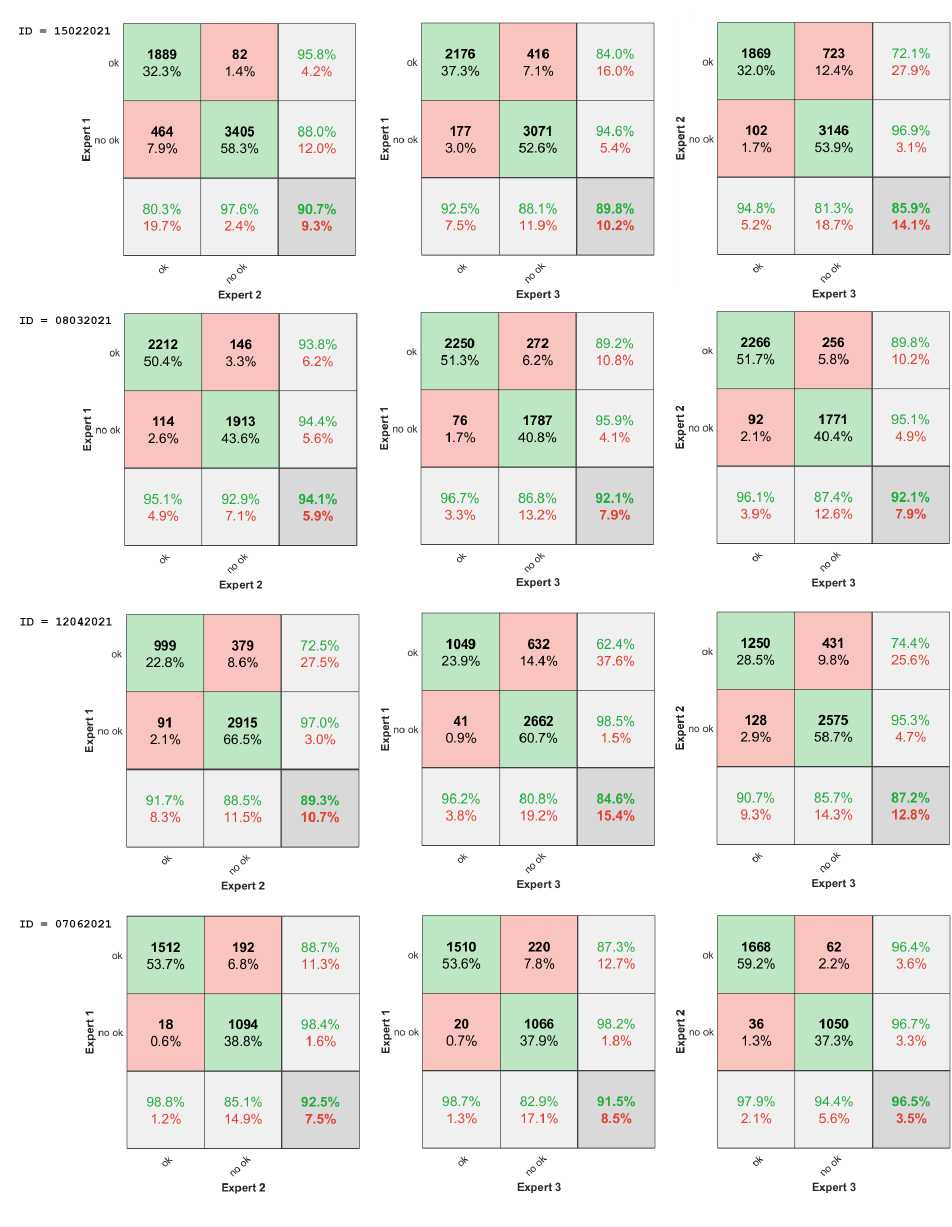
Figure 2. Inter/intra-observer agreement-confusion